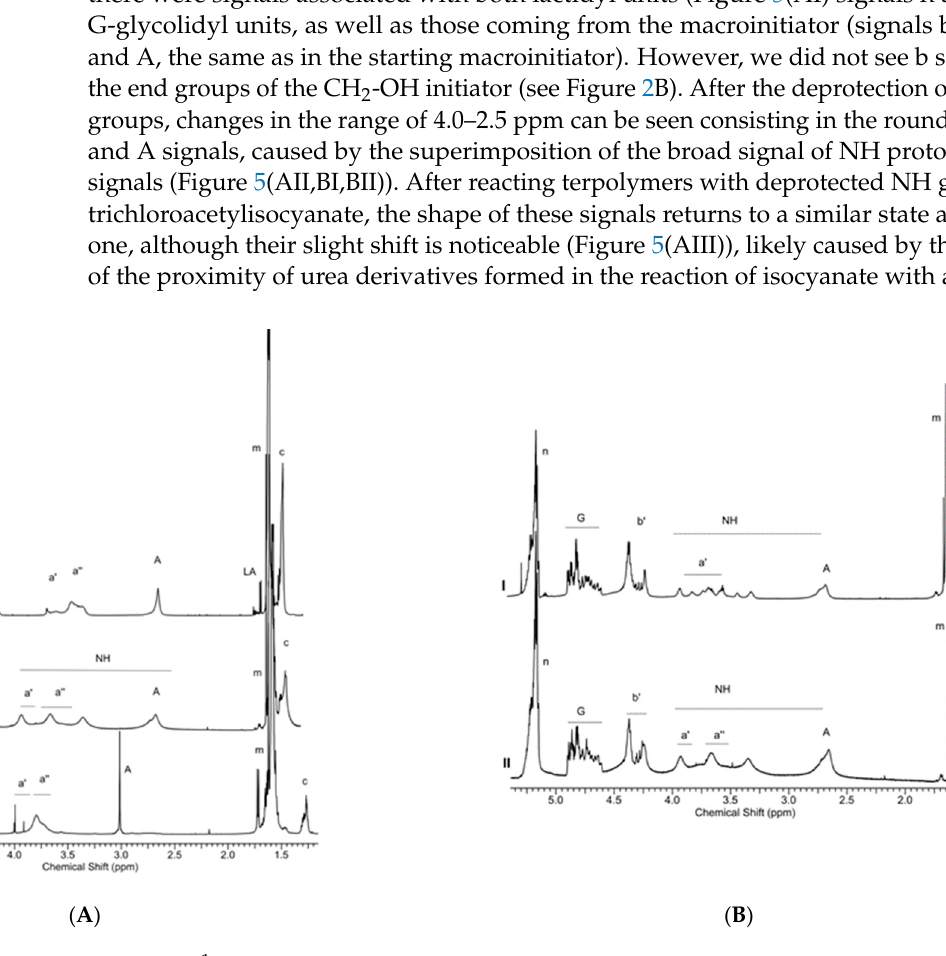
Figure 5. 1 H NMR spectra of the terpolymer obtained during copolymerization of L-lactide and glycolide: ( A ) terpolymer P7, with 17 mol.% of ester amine units, initiated by poly{(di-tert-butyl ethane-1,2-diylbis[(2-hydroxyethyl)carbamate] succinate)}; ( I )—with protected NH groups, ( II )— with unprotected NH groups, ( III )—with unprotected NH groups and after reaction with trichlo- roacetylisocyanate; ( B ) terpolymer with unprotected NH groups, ( I )—terpolymer P6 with 16 mol.% of ester amine units, initiated by poly(tert-butyl-bis(2-hydroxyethyl) carbamate succinate)}, ( II )— terpolymer P8 with 27 mol.% ester amine units initiated by poly{ (di-tert-butyl ethane-1,2-diylbis[(2- hydroxyethyl)carbamate] succinate)}.